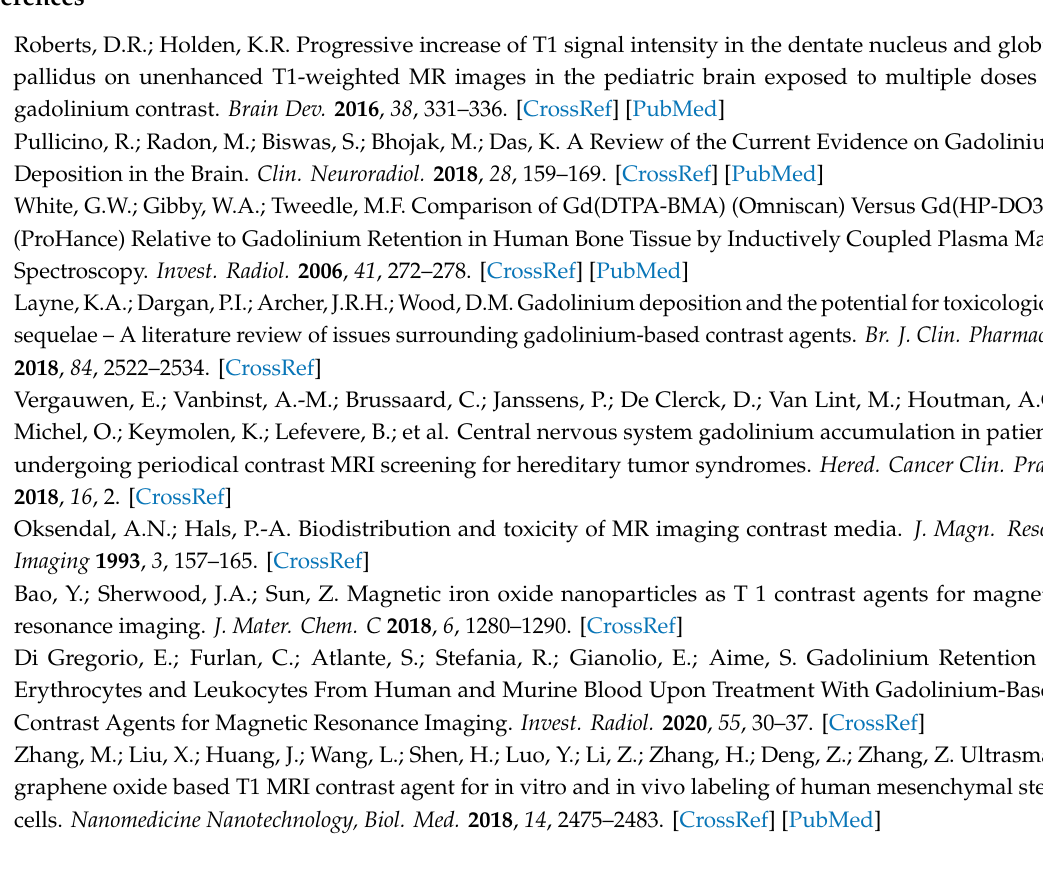
Figure S1: SEM images of ( a ) S, ( b ) LCS, and ( c ) HCS submicron